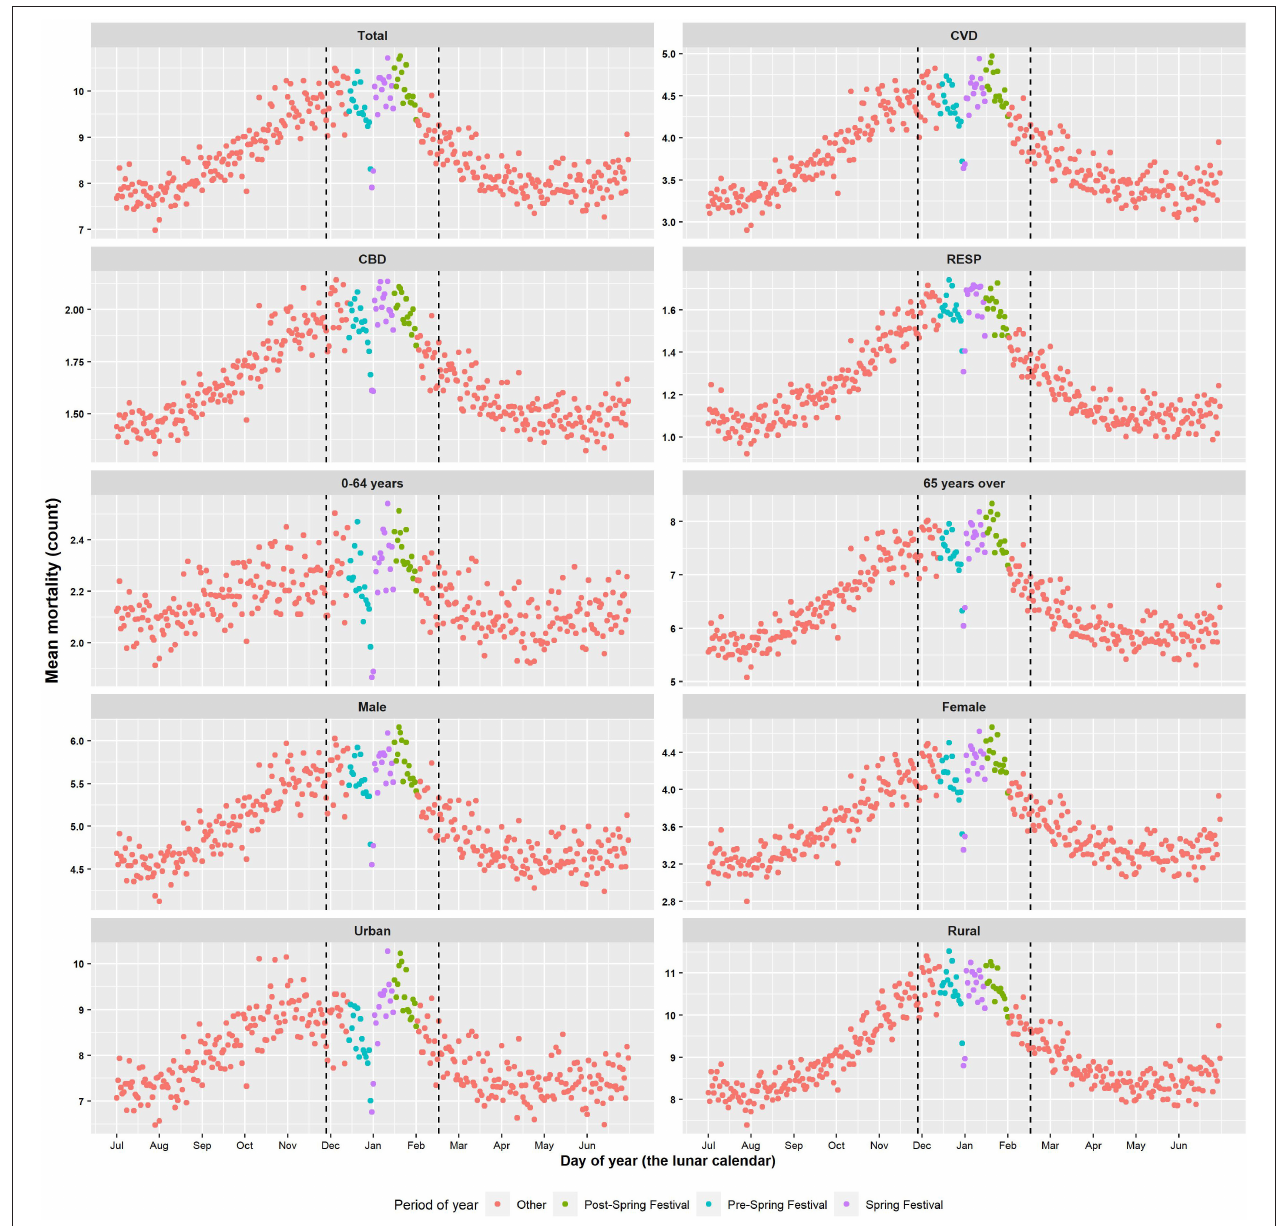
FIGURE 2 | Daily mean mortality distribution during 2013–2017 by sex, age, cause of death, and region.